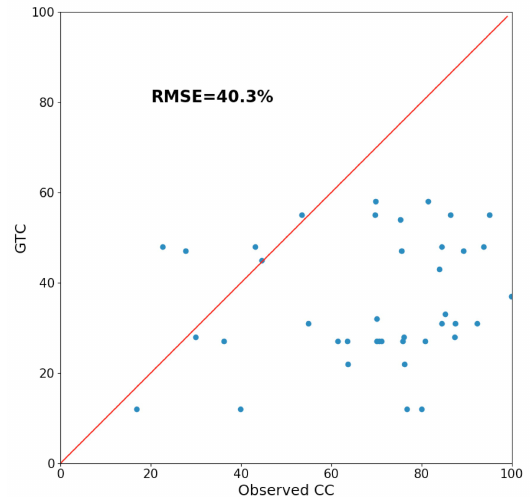
Figure 4. Comparison of measured CC and that obtained from GTC. GTC was underestimated compared to the measured CC. The RMSE was 40.3%.